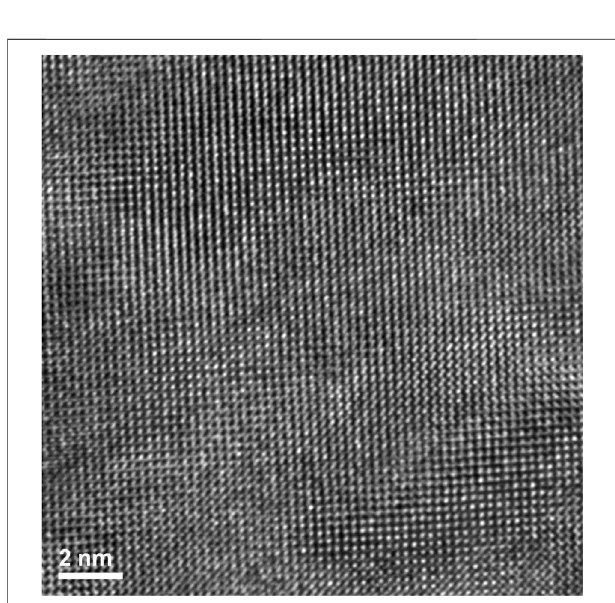
FIGURE11| LiftoutareaoftheirradiatedNd 2 Zr 2 O 7 sampleprepared via FIB. Thetwochosenareas containahigh andlowamountofsecond phaseof the altered pyrochlore phase after irradiation, respectively.